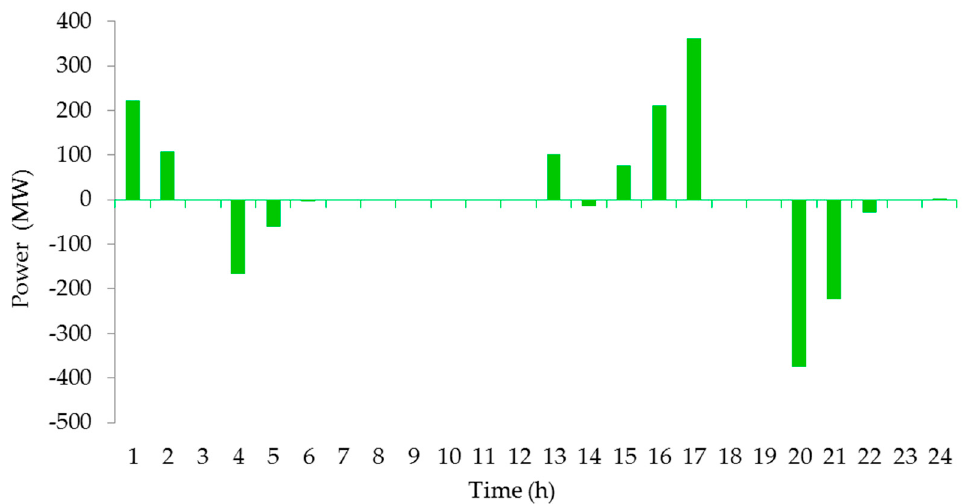
Figure 18. Power output curves of pumped storage generators in Case 3.